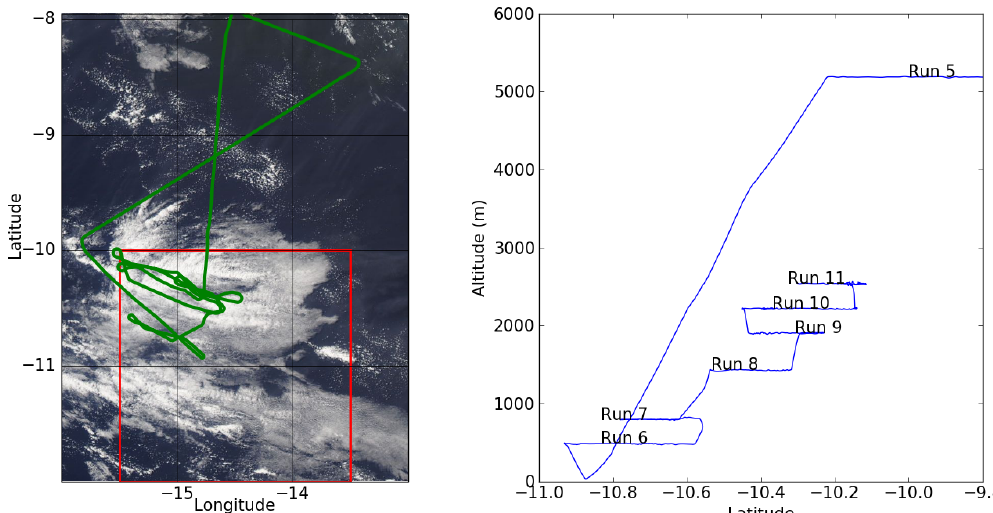
Figure 1. Flight pattern of the CLARIFY flight on 19 August 2017 used in the evaluations presented here (represented by the green line). The left plot is superimposed on imagery from MODIS on the TERRA satellite that corresponds to the morning of the flight, showing the cloud deck that was sampled. The red box corresponds to the domain of the 500m resolution simulation. The right panel shows the path of the aircraft as a function of height and latitude.